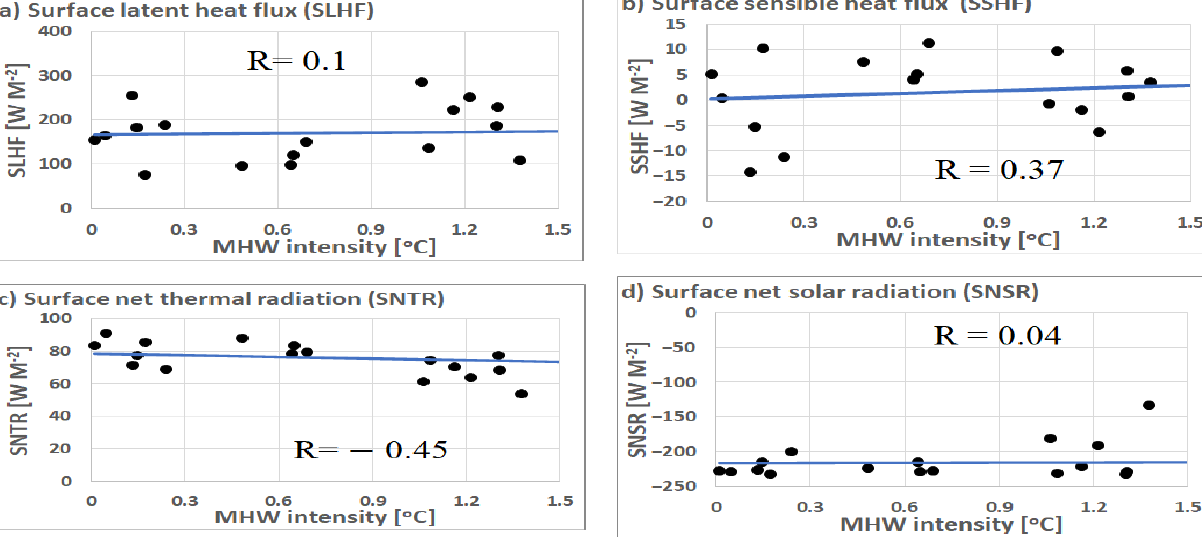
Figure 16. Scatter plots of marine heat wave intensity during the study case 3 (27 June 2019 to 22 July 2019) and surface latent heat flux ( a ), surface sensible heat flux ( b ), surface net thermal radiation ( c ), surface net solar radiation ( d ), and total heat loss to the atmosphere ( e ). The fourth study case, which peaked on 13 September 2020, extended over 85% (62% in moderate; 23% in strong) of the study area, most markedly around the northern side of the Red Sea (27.625° N and 34.875° E), as seen in Figure 17. Over the area centered around